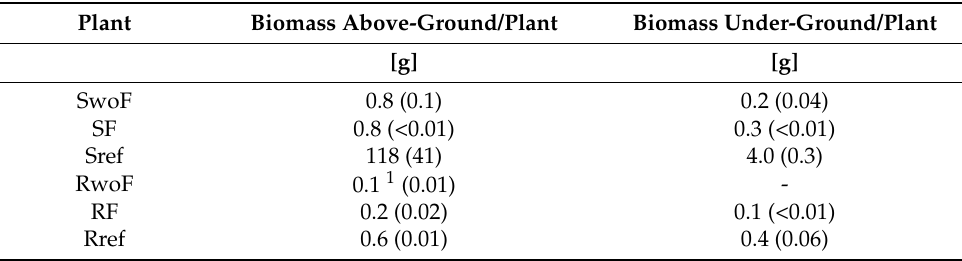
Table 2. Above- and under-ground biomass yield [g] for sunflowers and rapeseed cultivated in MIBA or reference soil (Sref and Rref) with SD in brackets.